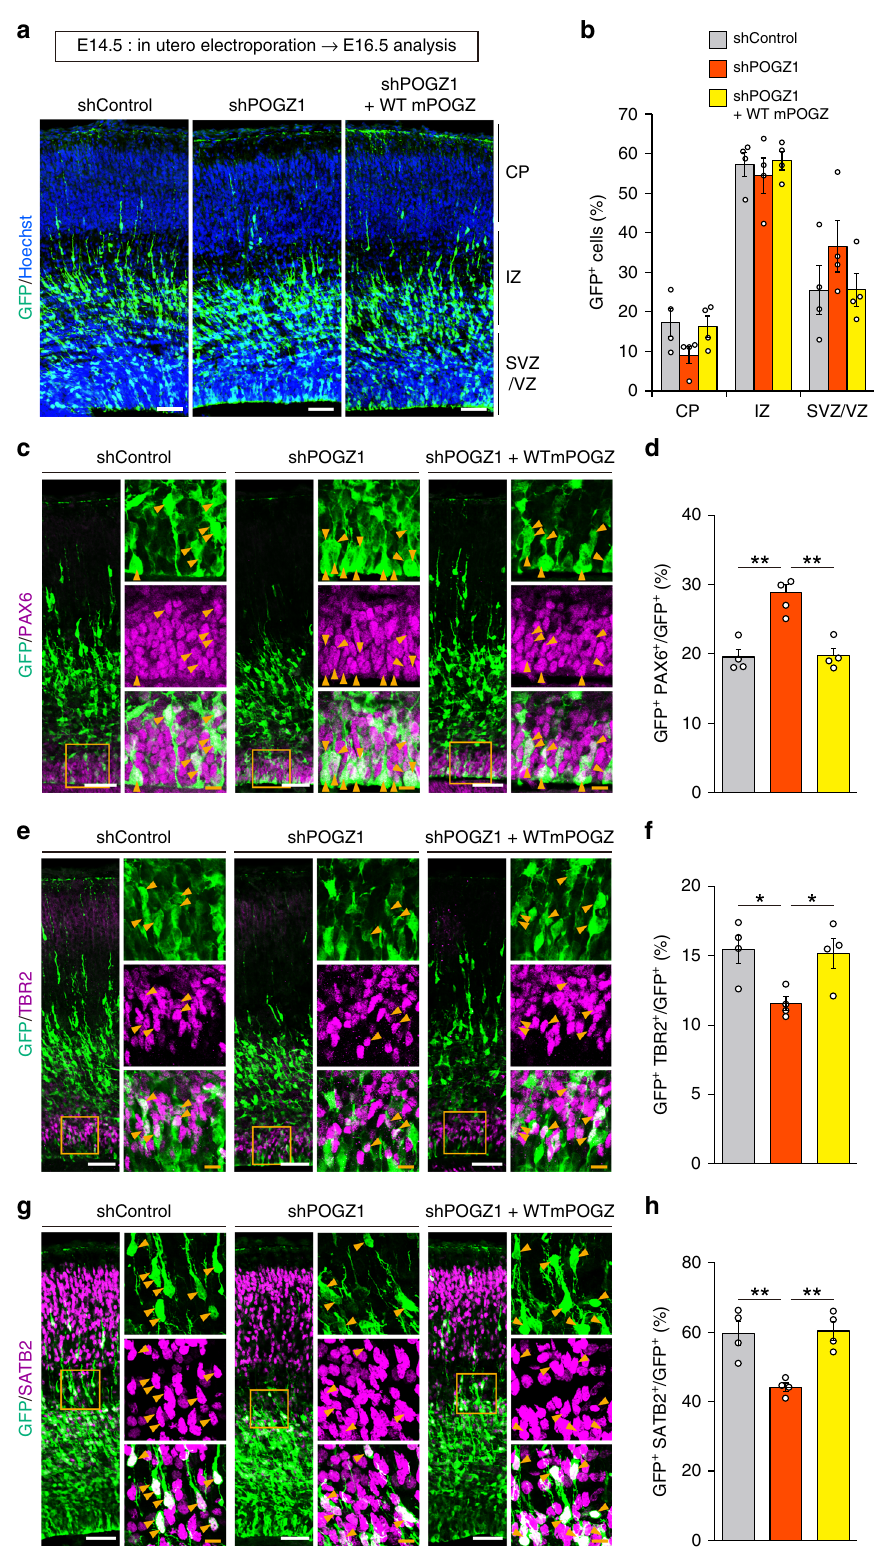
signi fi cantly attenuated in the patient-derived NSCs (Fig. 4h, i). Taken together, these results show that, consistent with the impaired cortical neurogenesis induced by Pogz knockdown in mice (Fig. 4a, b), the neuronal differentiation is impaired in patient-derived